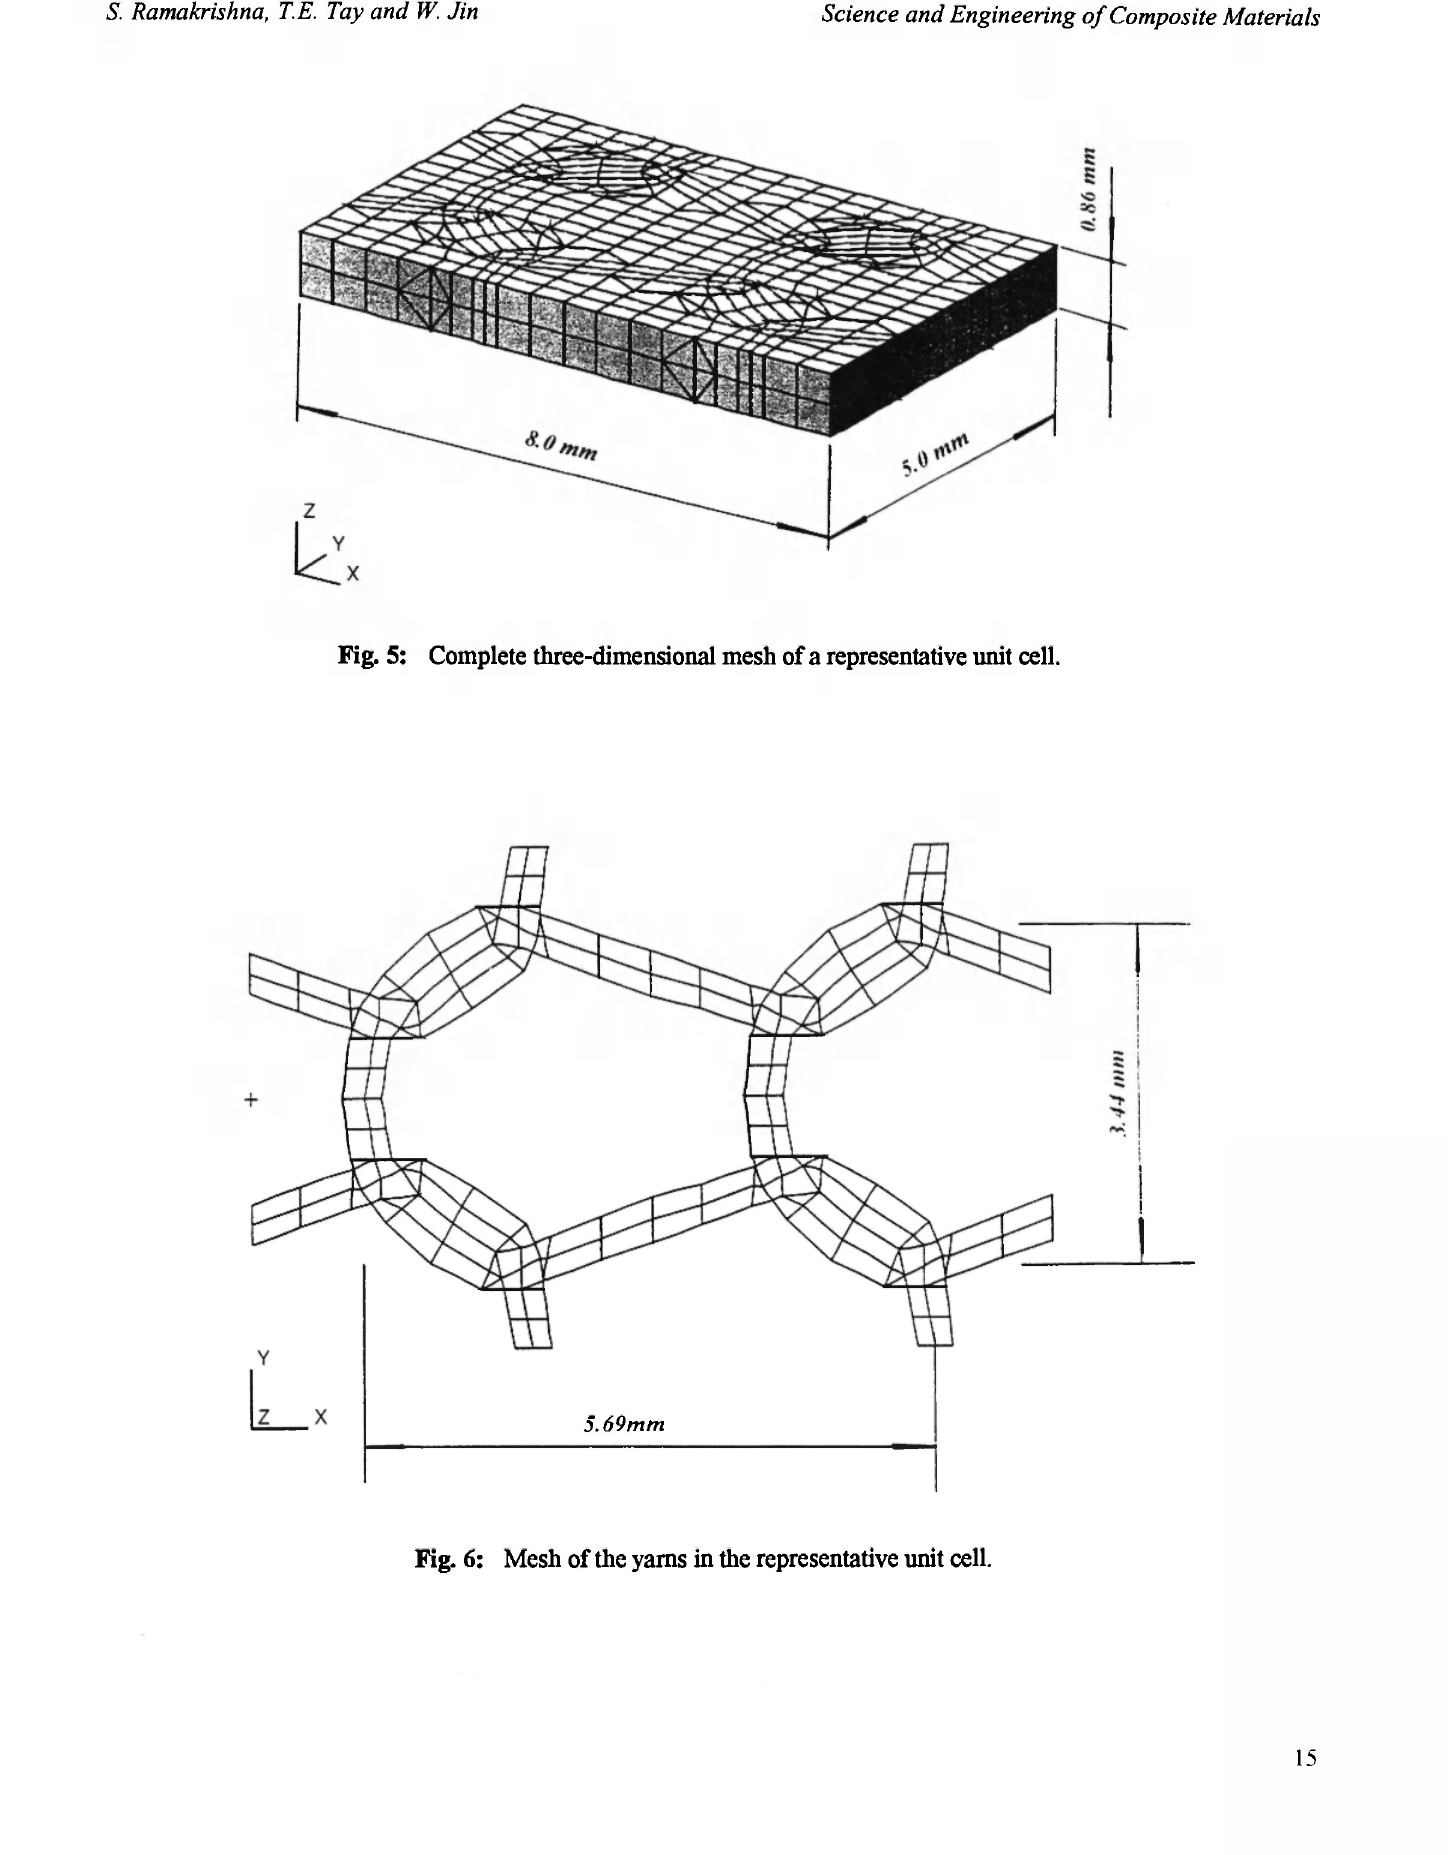
Fig. 6: Mesh of the yarns in the representative unit